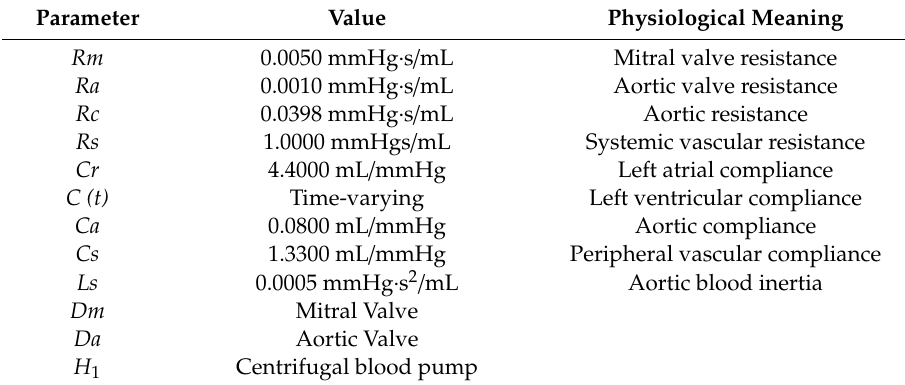
Table 4. State variables of the coupled